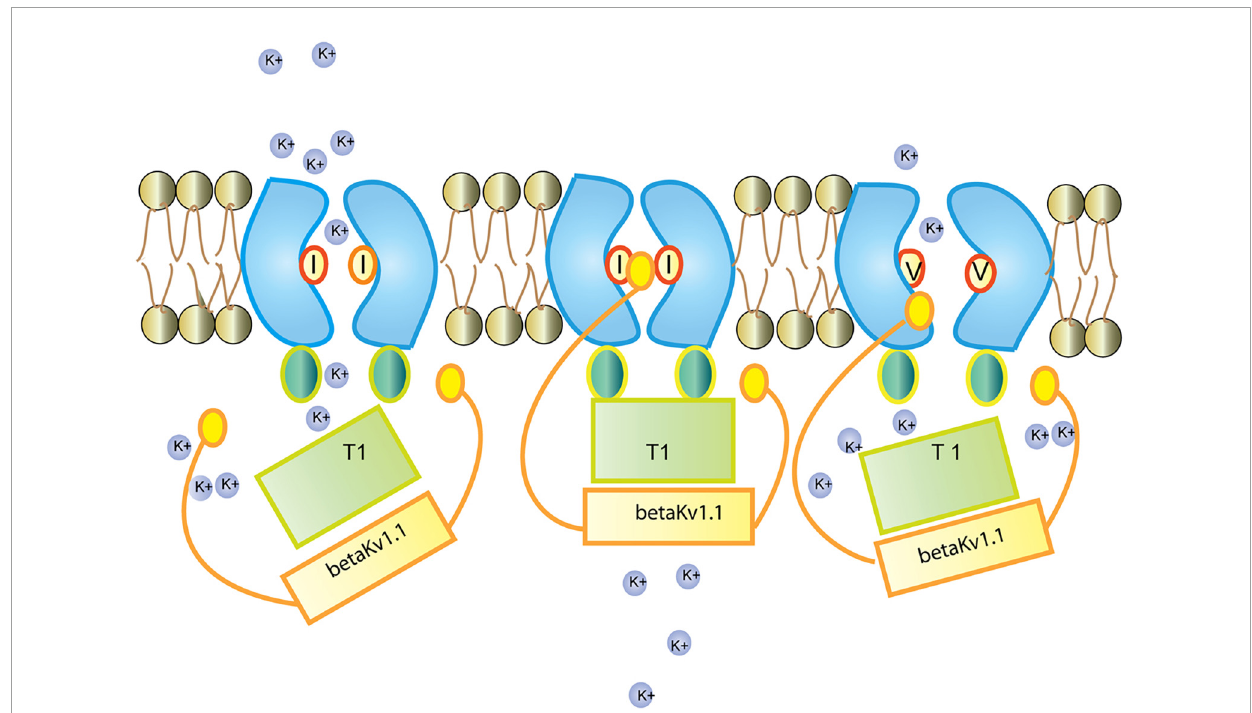
FIGURE11 Regulation of the Kv1.1 (KCNA1) channel by Kvb1.1 (KCNE5). Kvb1.1 has an inactivation gate which interacts with the unedited (I) form of the Kv1.1 receptor. Editing of Kv1.1 changes the isoleucine to valine (V). This reduces the affinity for Kvb1.1 and enhances recovery from inactivation. While all Kv channels (voltage-gated) function along the same principles (Grizel et al., 2014), different Kv channel subtypes show very different responses to short stimulation (Cameron et al., 2017). Figure from Tariq and Jantsch (2012), obtained under a creative commons license 3 and